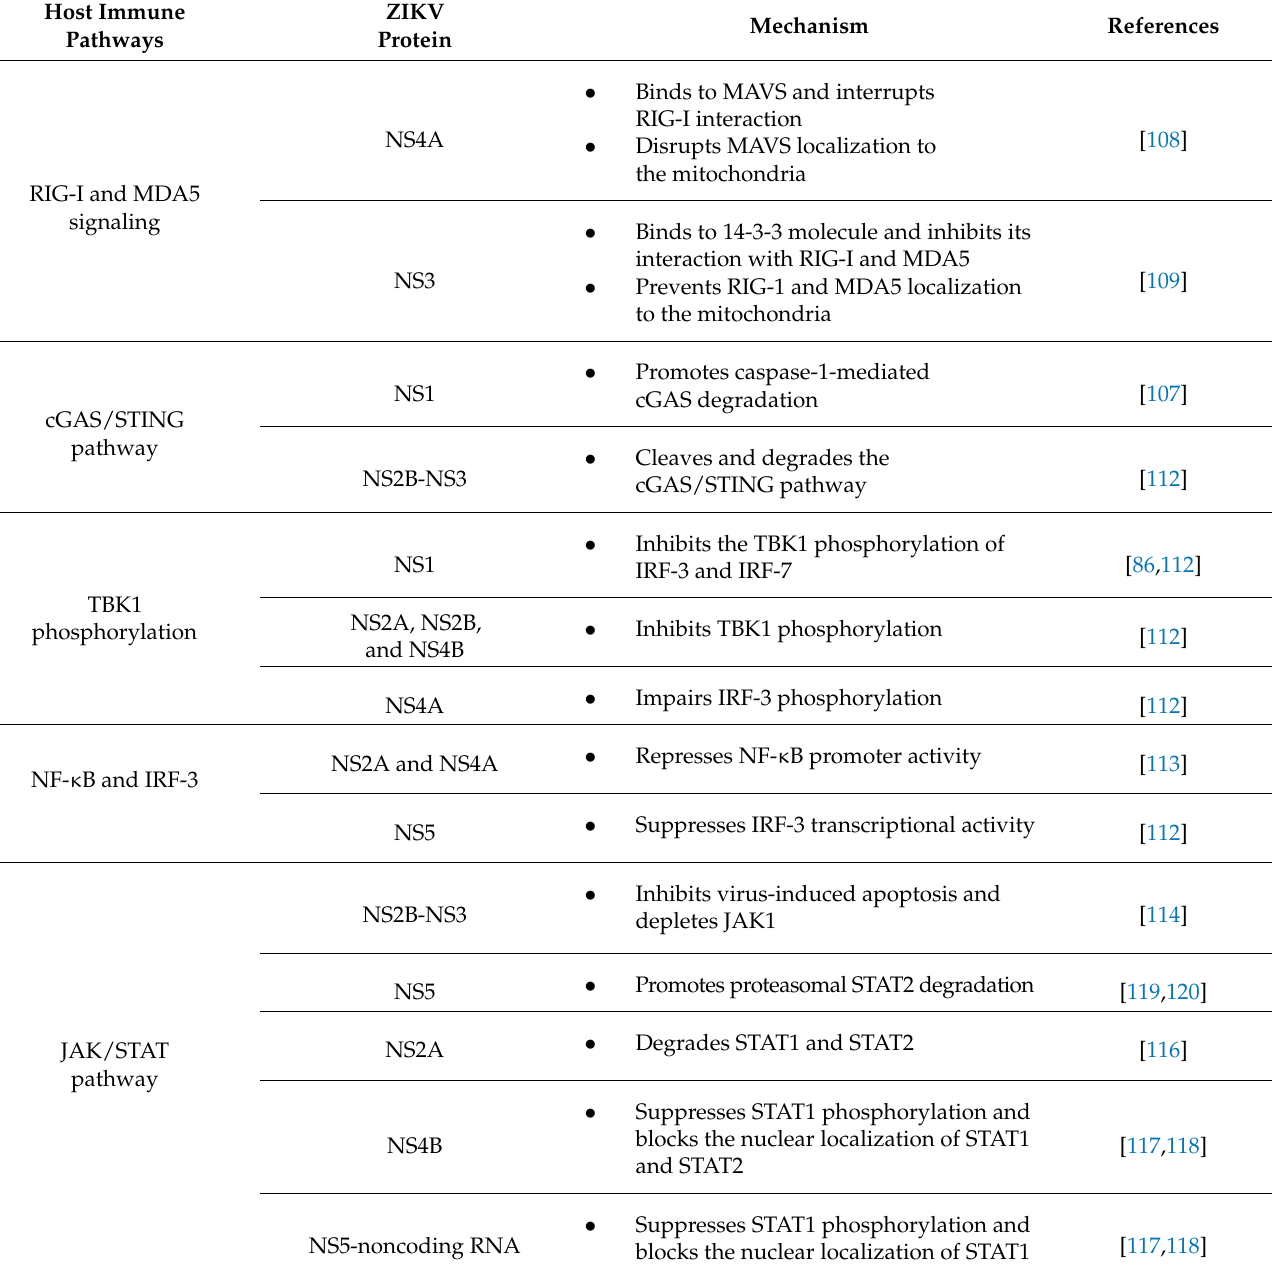
Table 1. Summary of the immune evasion mechanisms of